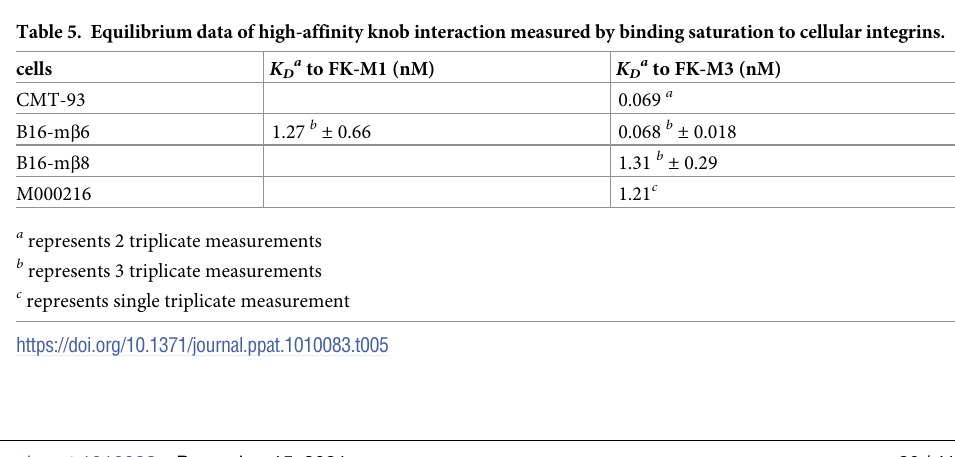
A20FMDV2 peptides (S1–S6 Datasets), using the co-structures of α v β 6 and α v β 8 with TGF- β 1